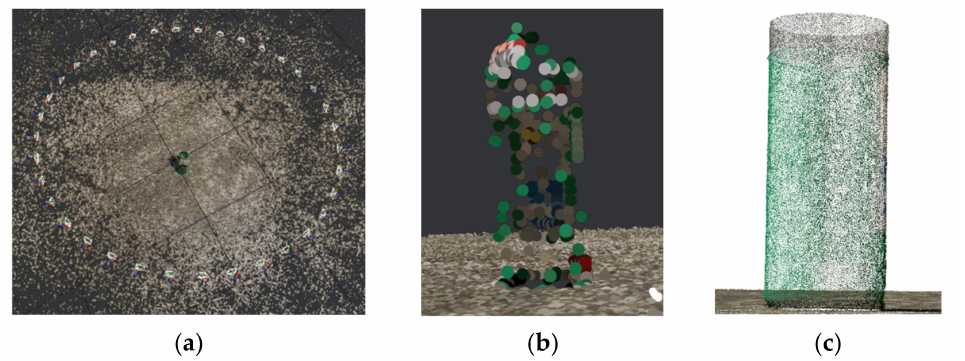
Figure 3. ( a ) Reconstructed cylinder point cloud with the Meshroom algorithm; ( b ) magnified view of the reconstructed point cloud in ( a ); ( c ) magnified view of the reconstructed point cloud in Figure 4c with Colmap algorithm.